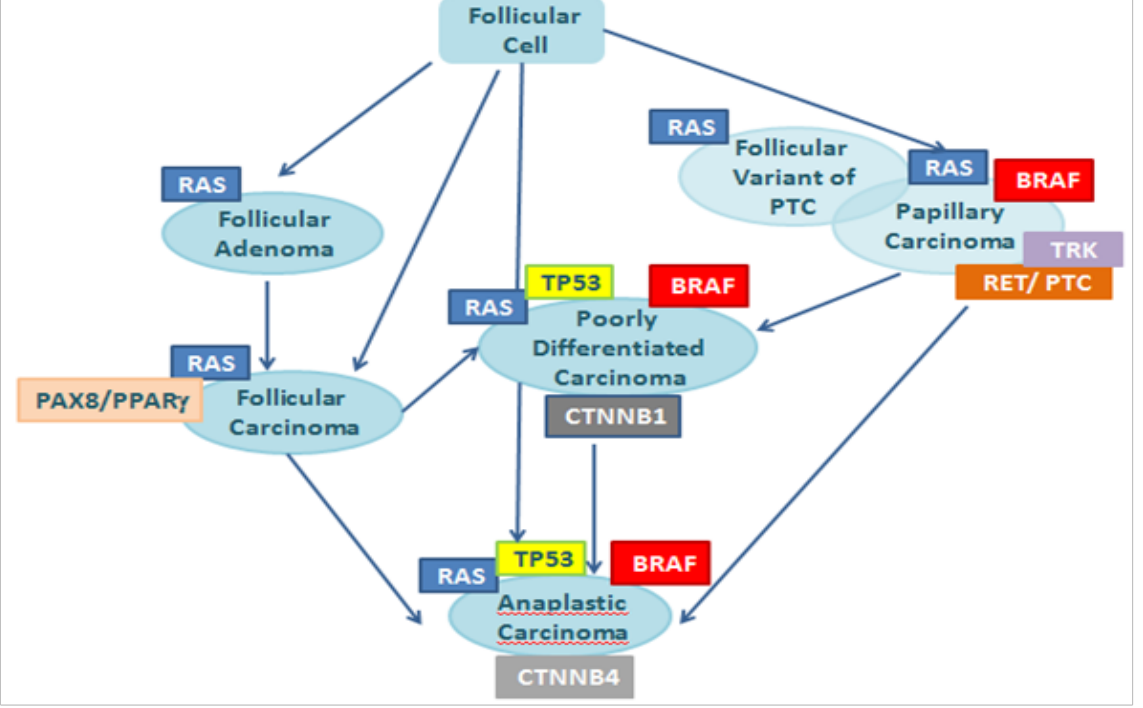
Figure 1. Stepwise dedifferentiation of follicular cell-derived thyroid